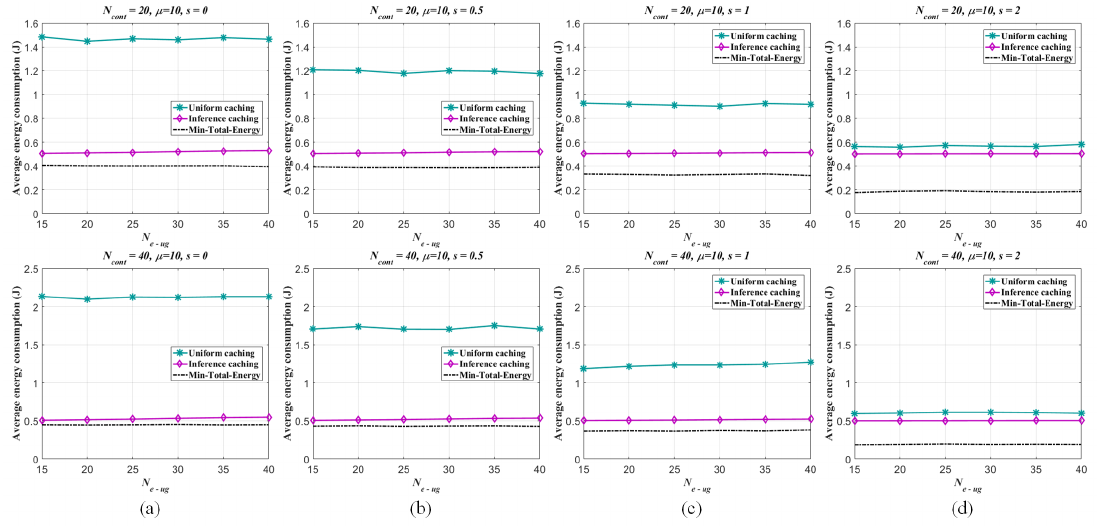
Figure 10. Average energy consumption of each eRRH in the F-RAN on the synthetic dataset ( J = W · sec). Two different edge caching strategies are considered: (i) uniform caching strategy via content Zipf distribution, (ii) inferring caching strategy via pre-mapping (inferred by ANNMC with non-uniform sampling rate p s = 0.2) and Zipf distribution. The average energy consumptions of both strategies are compared with the minimum consumption E min − total . The range of the eRRH/UE cluster number is varied from 15 to 40. The Zipf exponent s = 0,0.5,1,2, and ( a – d ) correspond to different s with µ = 10, N cont = 20 and 40.